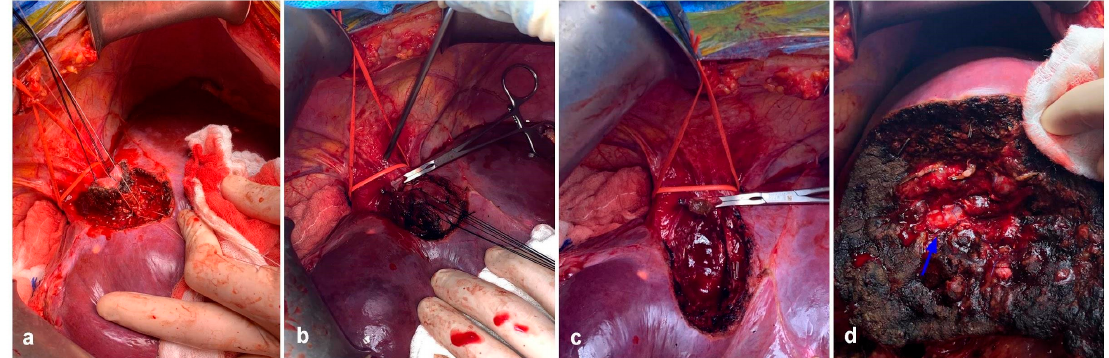
Figure 6. Parenchyma sparing surgery in a patient with a tumor located in the hepatocaval conflu- ence. ( a ) Careful separation of the tumor from the surrounding tissue was performed. A red vascular loop was placed around the hepatic vein confluence in case clamping was required, and the tumor was marked by several stay sutures to allow for better exposure. ( b ) Due to the tumor’s proximity to the middle hepatic vein, a partial resection was necessary, and a Kelly clamp was used for hemostasis. ( c ) The tumor was completely removed, the middle hepatic vein has been ligated, and the right hepatic vein repaired using a patch of falciform ligament, as shown in ( d ) with a blue arrow.